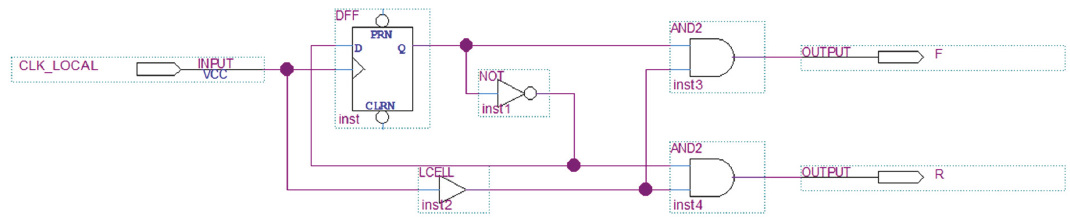
Figure 6: Schematic of biphasic clock source circuit.